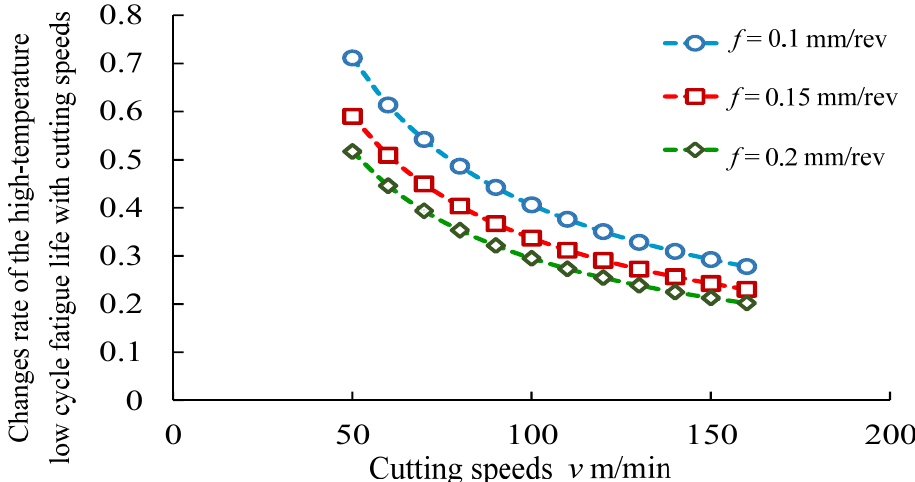
Figure 16. Sensitivity analysis of high-temperature low-cycle fatigue life to cutting speeds.